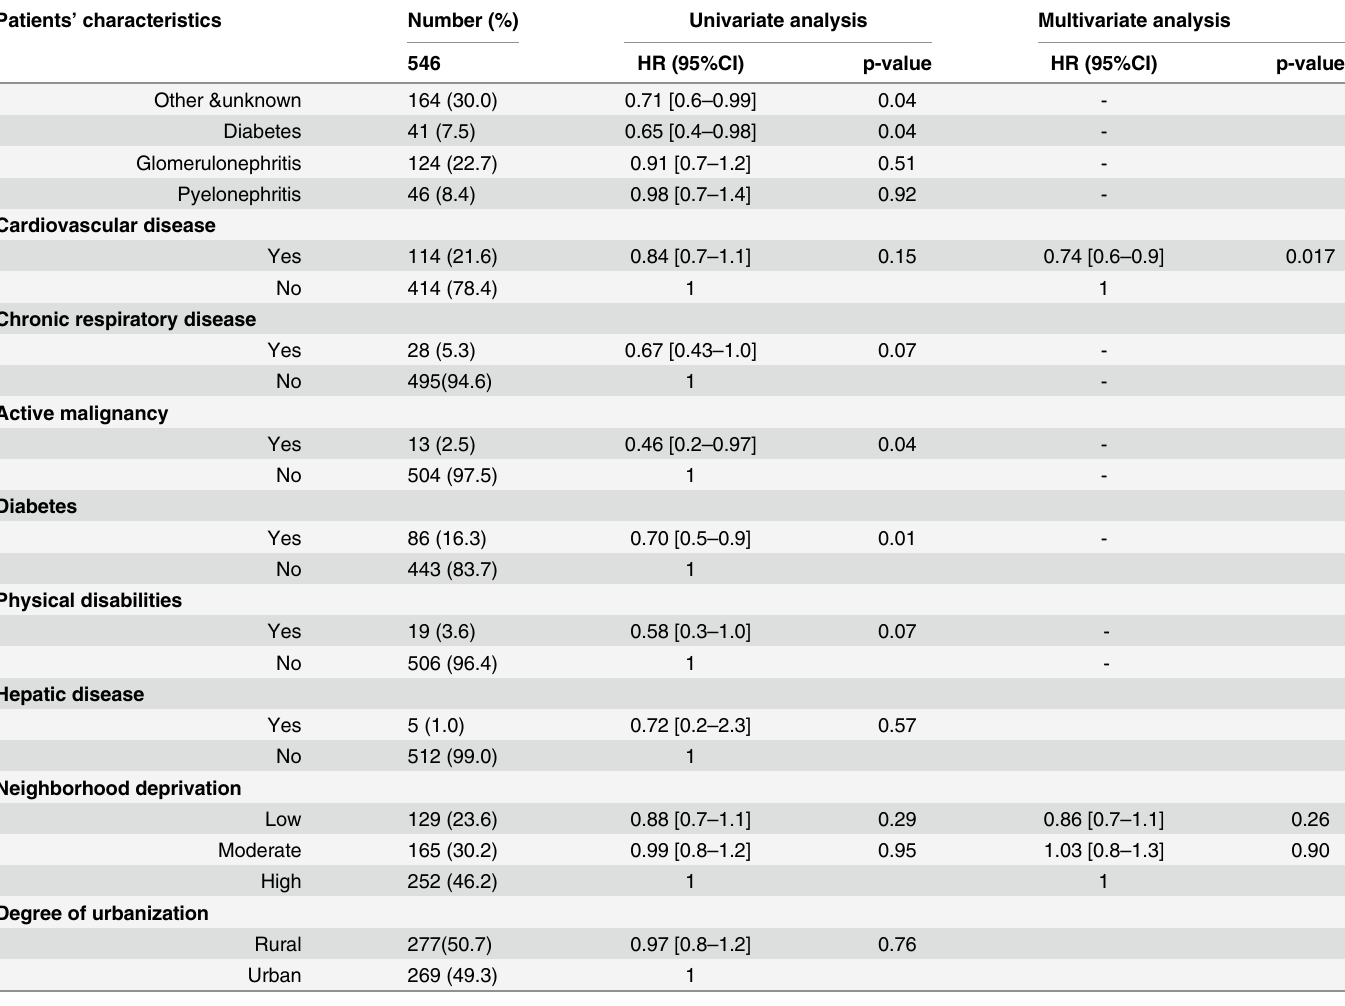
diabetes and active malignancy at first dialysis, diabetic nephropathy (compared with polycys- tic kidney disease) and hyperimmunisation (PRA (cid:1) 85%) were associated with lower access to cantly associated with access to renal